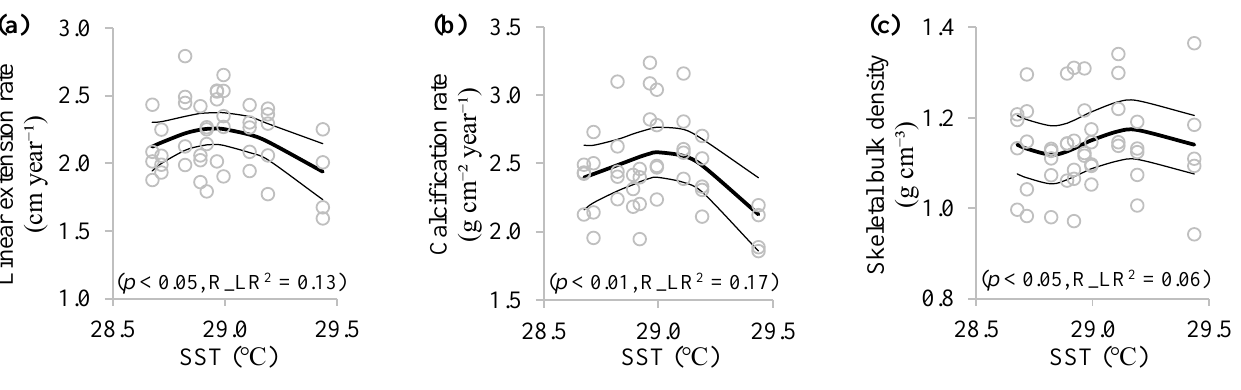
Figure 4. Plots show relationships for ( a ) linear extension rate, ( b ) calcification rate, and ( c ) skeletal bulk density with SST. The significances of relationships at p < 0.01/0.05 and R_LR 2 are shown in brackets. Gray circles: annual data, black lines: best fit regression line with 95% confidence intervals.